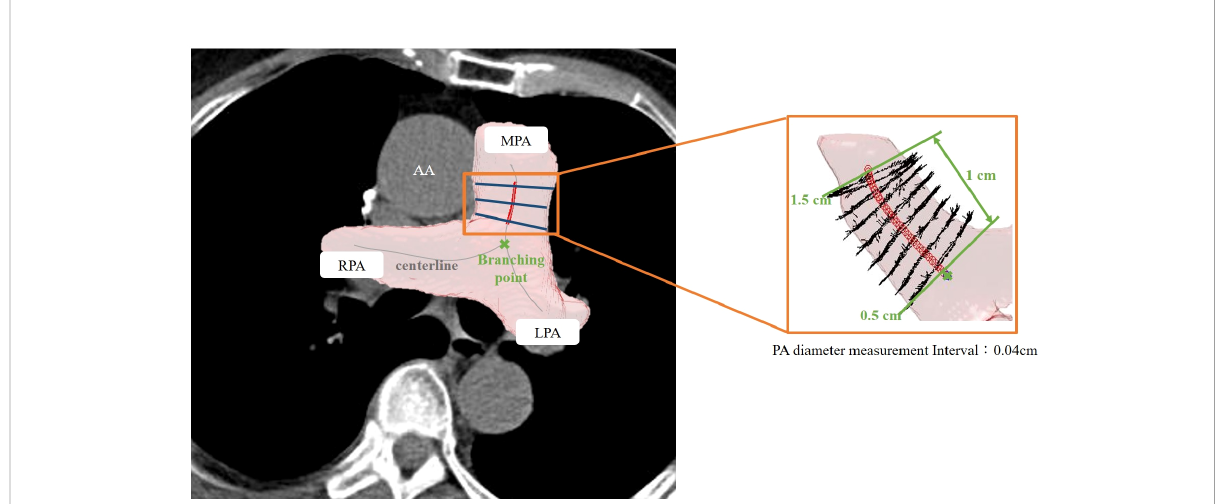
FIGURE 4 Illustration of 3D automated measurement of pulmonary artery (PA) diameter. The centerline was marked on the 3D segmented image. The PA diameter was measured on the main PA between 0.5 to 1.5 cm from the branching point. The PA diameter was de fi ned as the mean value of calculated diameters at every 0.09-cm